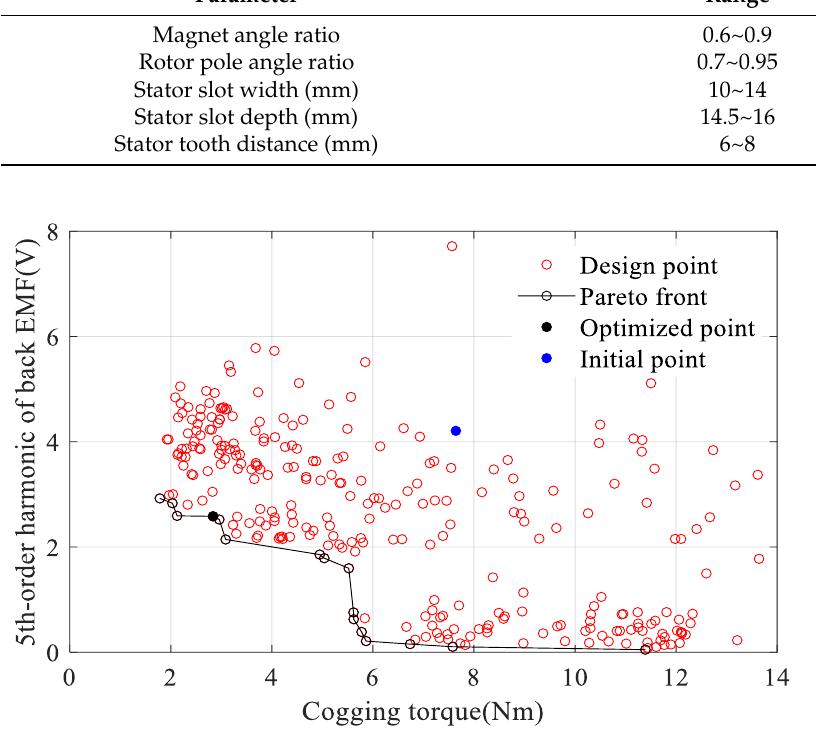
Figure 9. Pareto front of GA optimization.